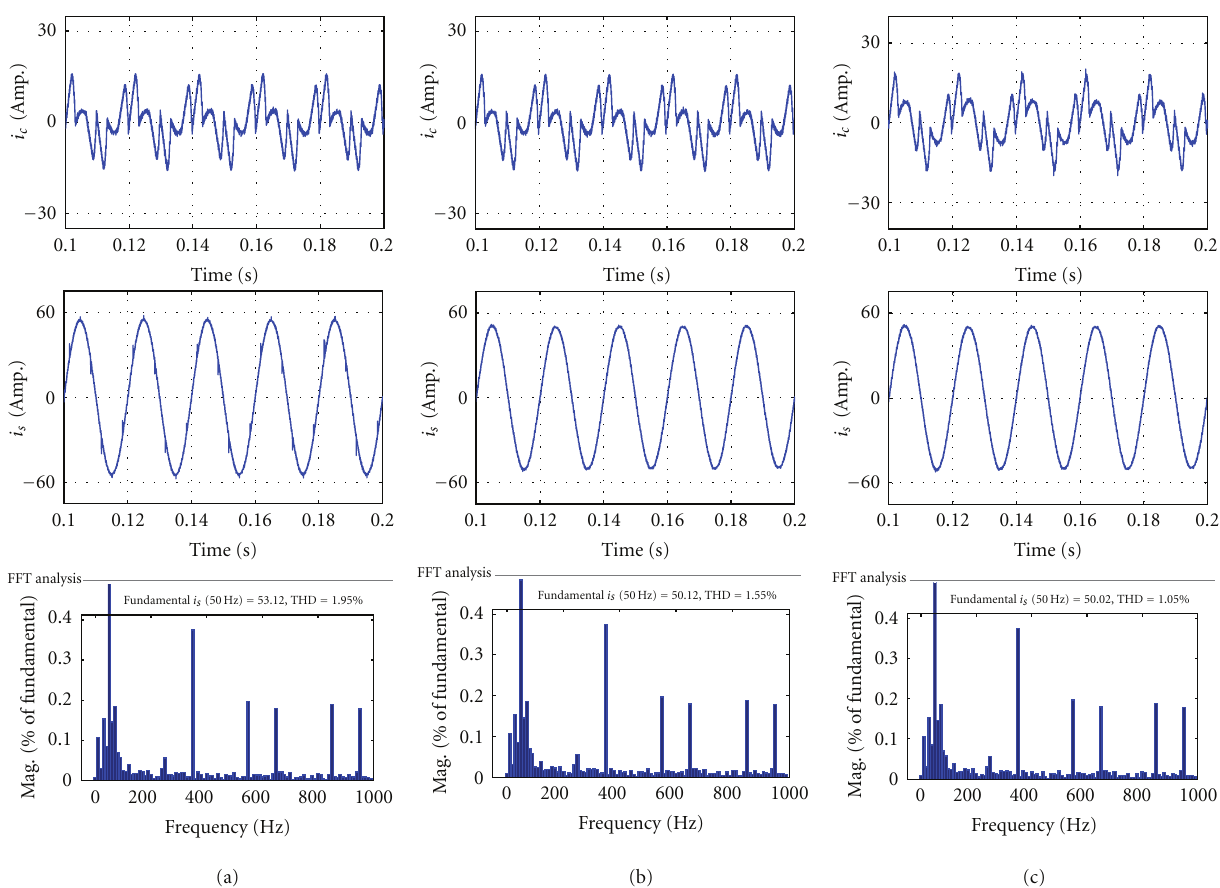
Figure 9: Compensation filter current, compensated source current, and FFT analysis showing THD in source current in top to bottom order with ideal supply for (a) conventional, (b) PSO-based, and (c) BFO-based APFs.